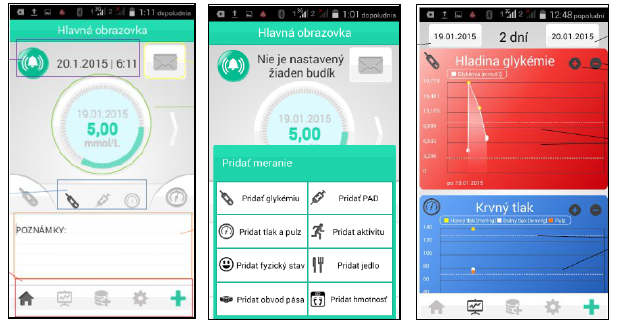
Figure 2. Mobile phone displaying the main screen with basic information and options, measurements and data entry menu, and graphical historic